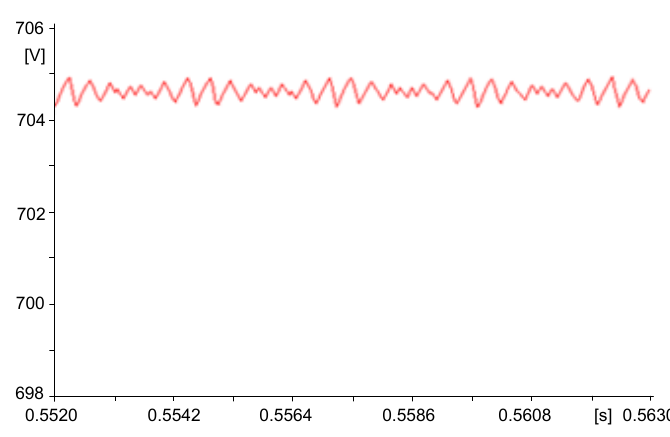
Figure 12. Current drawn to ground through the capacitance C